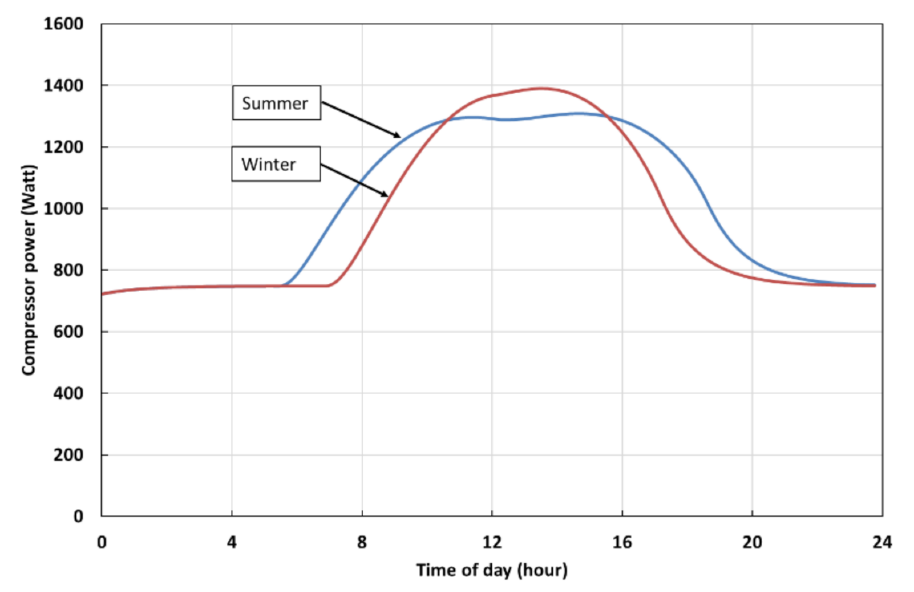
Figure 15. Compressor thermal power required to keep the cold storage temperature at 5 ◦ C in mid-summer and mid-winter for a cold storage container orientated with the container face wall, normal to east, with all the container walls shaded.